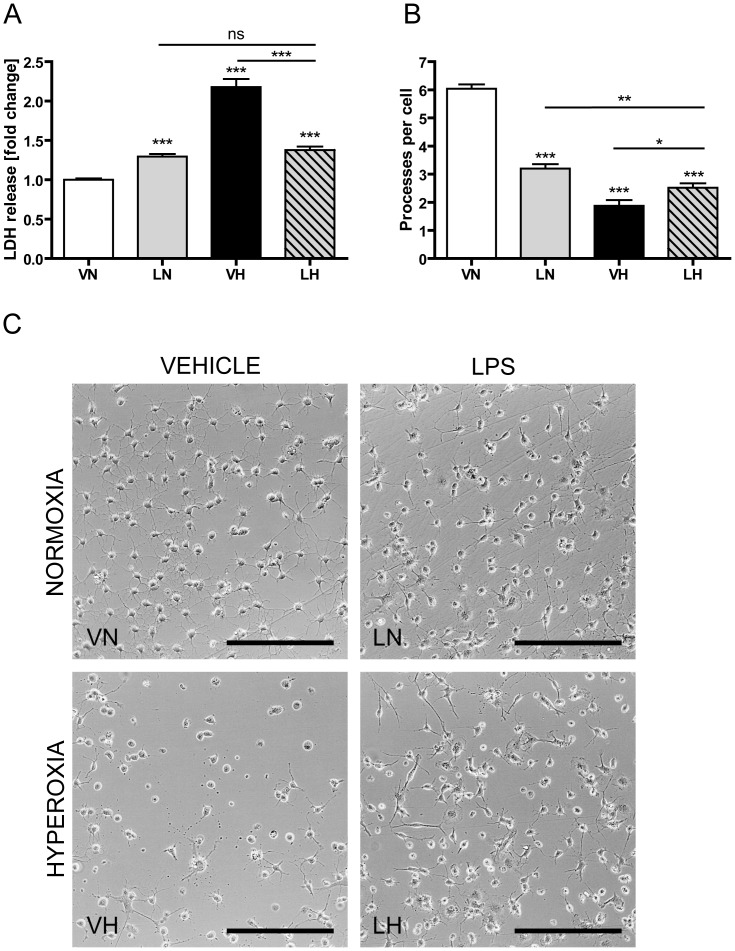
LPS pre-treatment reduces pre-OL susceptibility towards hyperoxia.Primary oligodendrocyte-microglia-co-cultures were stimulated with LPS 24 h before exposure to 80% oxygen for 8 h. Results of a cytotoxicity assay, based on LDH release (A), data of morphological analysis by counting of processes per cell (B) and representative images of the oligodendrocyte-microglia-co-cultures are shown (C). LPS stimulated co-cultures have a slight increase in LDH release but a distinct loss of processes per cell (LN, grey bars) whereas hyperoxia induces profound cell death and numerous cells detached from the culture plate (VH, black bars). Co-cultures exposed to the two-hit scenario are more resistant against hyperoxia (LH, dashed bars). Five independent experiments were used for data collection and means+SEM were shown. One image out of the center of the well was used for counting processes for each group and experiment. Scale bar = 200 µm, * p<0.05, ** p<0.01, *** p<0.001 and ns p>0.05; VN: vehicle+normoxia, LN: LPS+normoxia, VH: vehicle+hyperoxia, LH: LPS+hyperoxia.